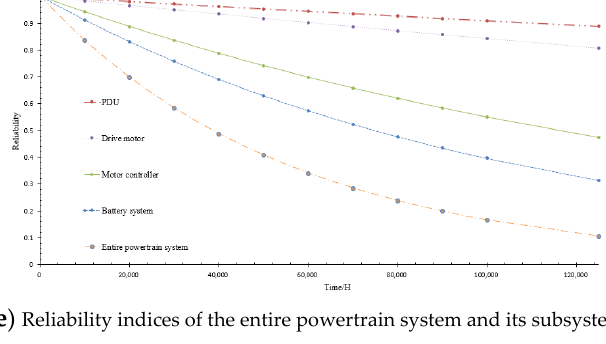
Figure 8. Reliability indices of powertrain system.